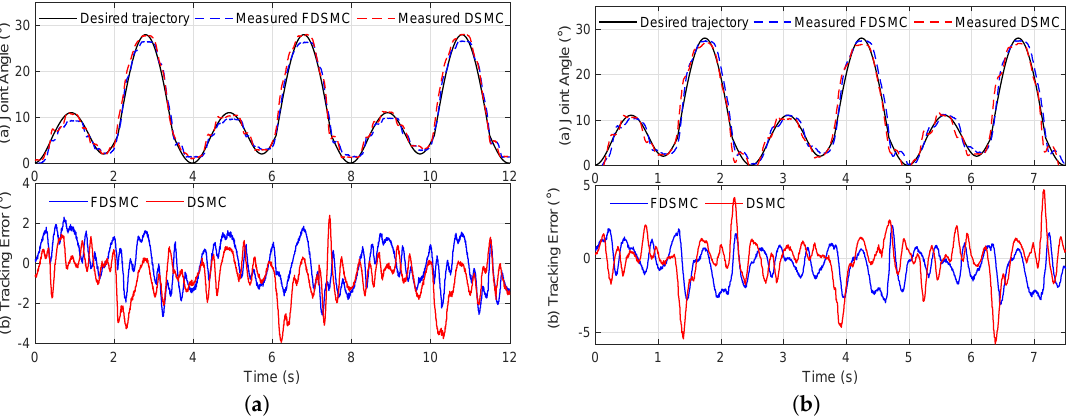
Figure 8. Experiment results for the proposed controller and conventional DSMC controller when tracking the human-gait pattern signal with a load m = 2.5 kg: ( a ) 4 s and ( b ) 2.5 s of gait cycle